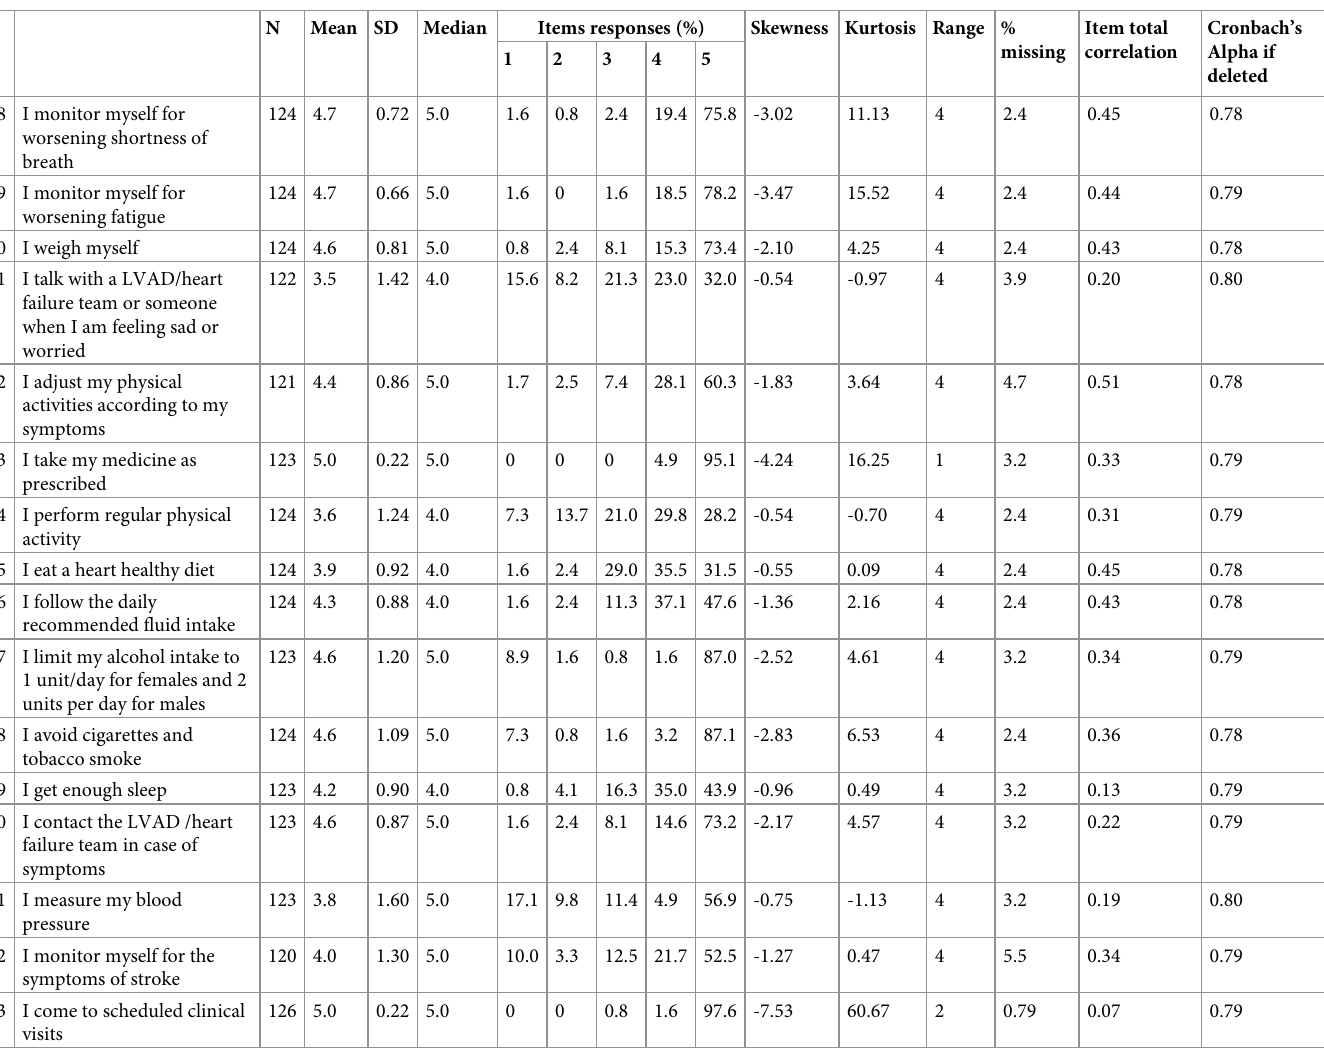
and its clinical irrelevance to new device design; and item 6 (wear a stabilisation device) since it is not relevant for self-care at home. After discussion among the research team, item 30 (con- tact the LVAD /heart failure team in case of symptoms) and item 21 (talk with the LVAD/ heart failure team or someone when I am feeling sad or worried) were excluded because of their redundancy. Item 10 (I inspect all cable connectors and the driveline for dirt or damage) overlapped with item 7 (I keep the exit site and the driveline clean and dry), making the weight of the cable inspections too heavy in the scale; hence item 10 was removed. As Step IV, an exploratory factor analysis of 20 items was performed. The results showed that the data set was adequate [(KMO) coefficient = .79, Bartlett Sphericity Test ( χ 2) = χ 2 = 834.8, p < .000)]. Three factors explained 46.7% of the total variance of the scale, and the 20 items were classified into three subscales, based on factor loading and clinical relevance, as follows (Table 4): Factor 1 Monitoring, Factor 2 HF self-care, and Factor 3 LVAD